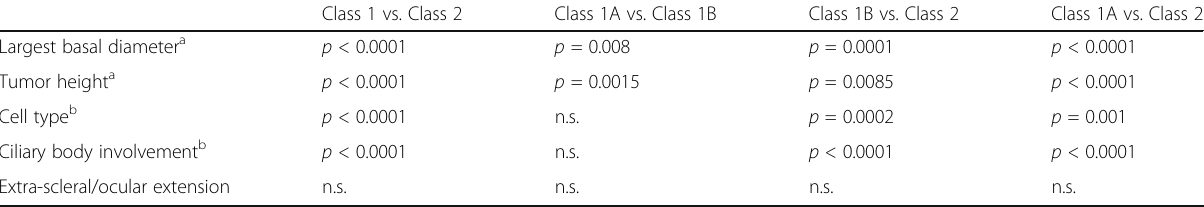
Table 4 Statistical comparisons between molecular class and tumor pathology in enucleated